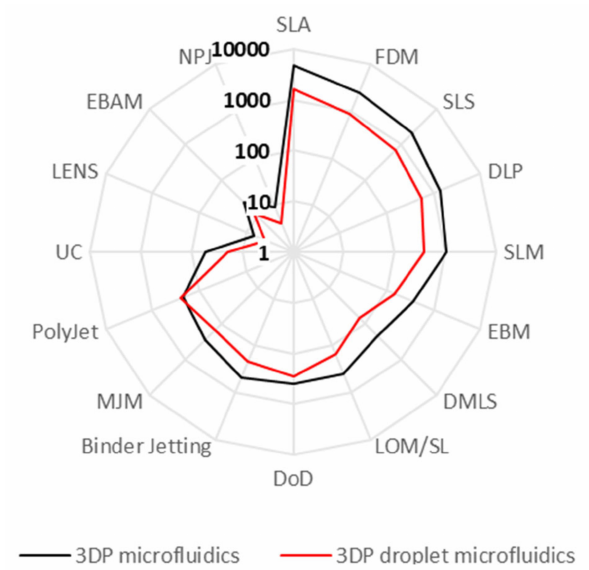
Figure 2. In the last five years, stereolithography has been by far the most popular 3D printing method for microfluidics. Based on the number of publications in the index of Google Scholar from the last five years, stereolithography (SLA) has been by far the most popular printing method for 3DP microfluidics, followed by fused deposition modeling (FDM), selective laser sintering (SLS) and digital light projection (DLP). However, from the 106 papers analyzed in this review, none used SLS for printing channels. Likely, SLS was used for other purposes, such as printing supporting infrastructure or tissue scaffolds connected to microfluidic systems. Abbreviations of all the listed 3DP methods are defined in Table S3 in supplementary material